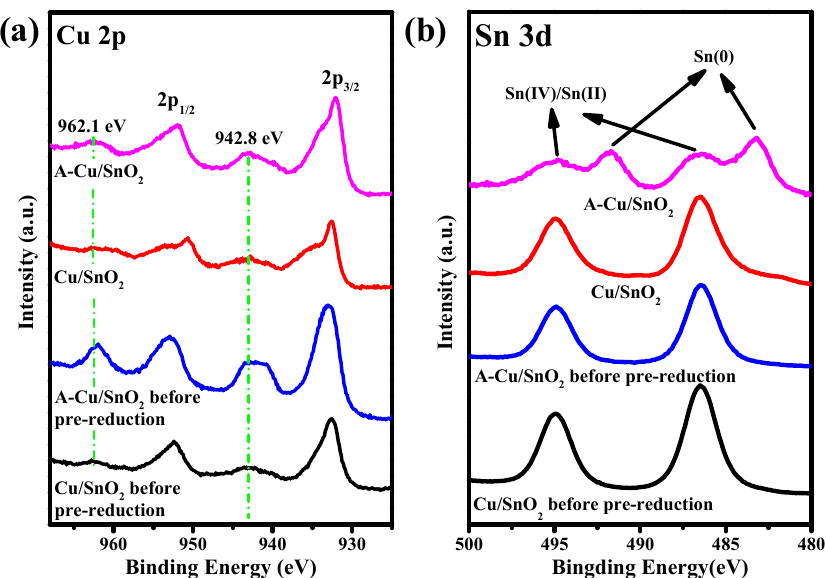
Figure 4. ( a ) Cu 2p X-ray photoelectron spectroscopy (XPS) spectra, ( b ) Sn 3d XPS spectra for Cu/SnO 2 , A-Cu/SnO 2.